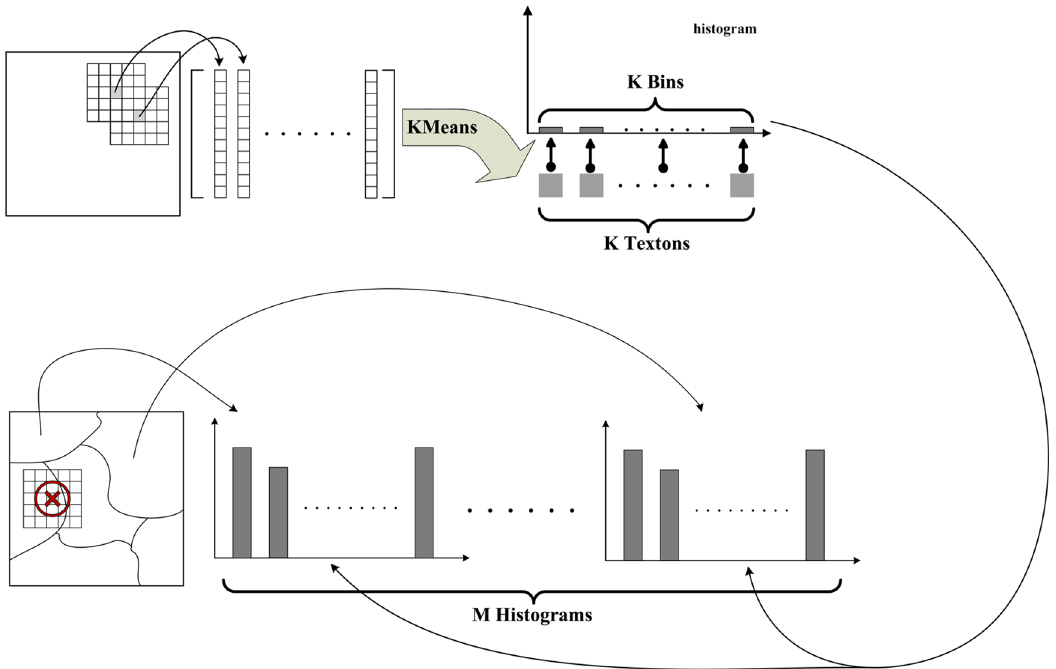
Fig 5. Diagram of superpixel feature extraction.